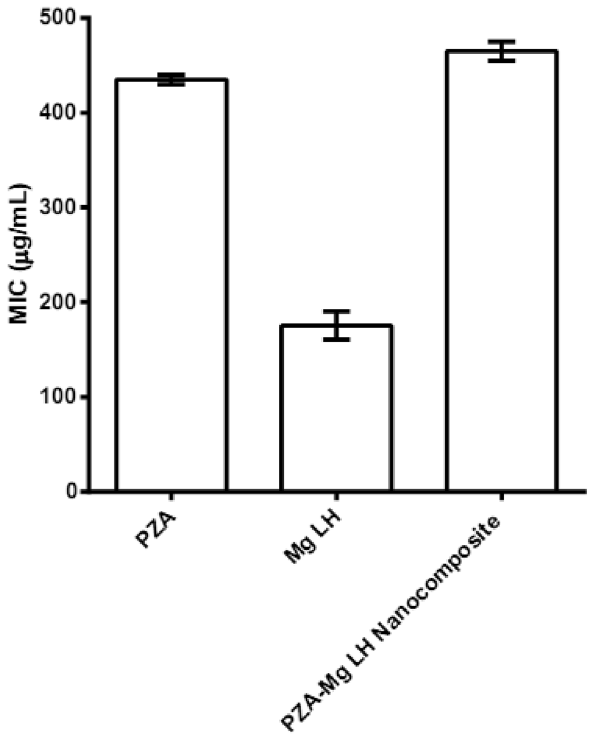
Figure 6. Minimum inhibitory concentrations (MICs) (µg/mL) of Mg-LH and PZA-MgLH nanocomposites as compared to the free drug PZA against Mycobacterium tuberculosis as determined using the Mycobacteria Growth Indicator Tube (MGIT) with BACTEC MGIT 960 growth supplement for drug susceptibility testing and measured using the MGIT 960 instrument (Becton Dickinson Diagnostic Systems, Sparks, MD, USA). Data = mean ± SEM; N = 3; all values statistically (p < 0.01) different than each